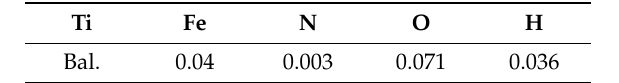
Table 2. Chemical composition (wt. %) of 304 stainless steel.